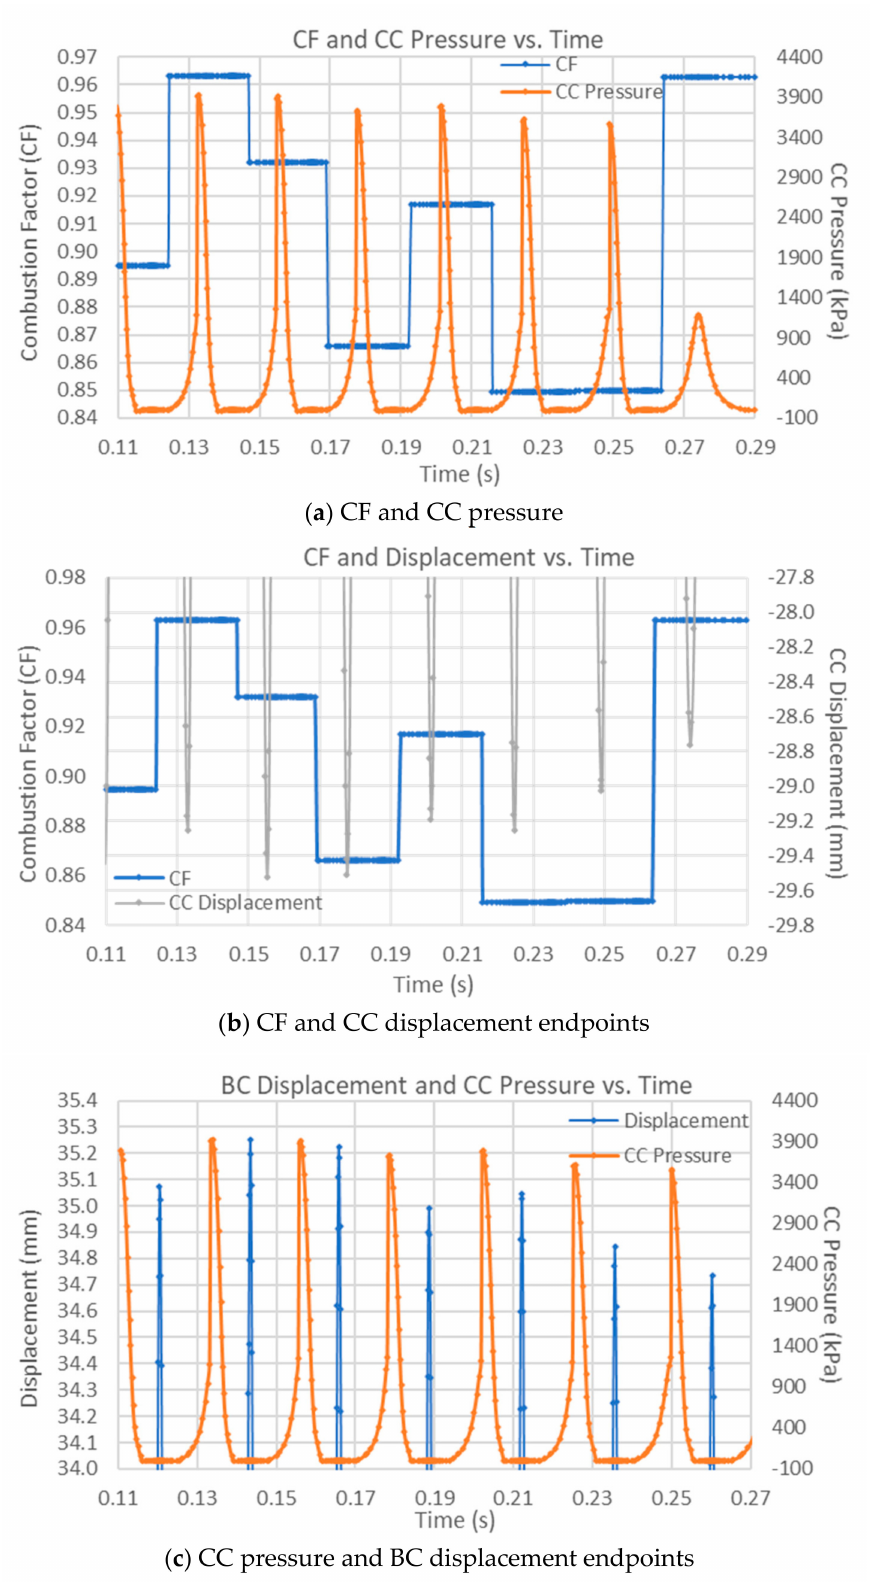
Figure 19. ( a ) CF and CC pressure vs. time, ( b ) CF and CC displacement endpoints vs. time, ( c ) CC pressure and BC displacement endpoints vs. time at 0.89 ±